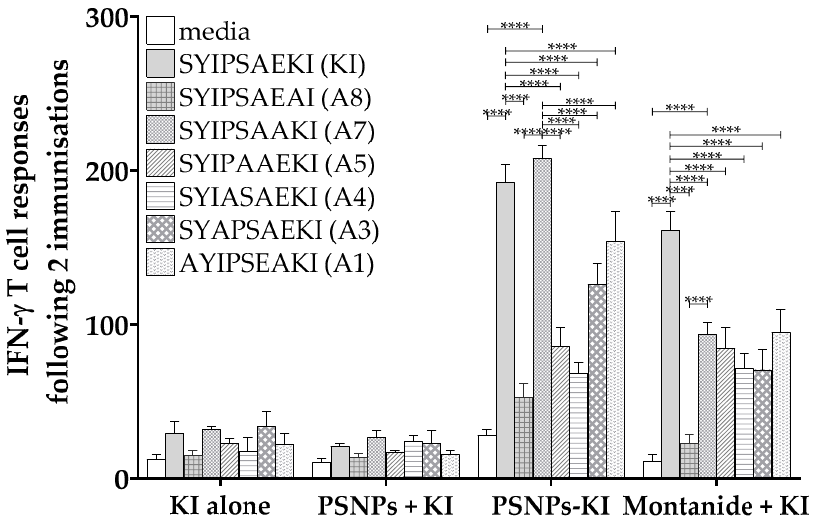
Figure 2. Different patterns of IFN- γ reactivity to alanine altered peptide variants with Montanide adjuvanted or conjugated PSNPs immunized mice. The 6-8 week old BALB/c mice were immunized twice with KI peptide alone (25 µg KI per mouse), PSNPs plus KI (PSNPs + KI) or KI conjugated to PSNPs (PSNPs-KI) (25 µg per mouse KI and 1% solids PSNPs for both groups), or Montanide plus KI (25 µg KI per mouse in 70%/30% v / v Montanide/PBS). Two weeks after the last immunization, splenocytes from immunized mice were harvested and restimulated with altered peptides in an in vitro ELISpot assay for IFN- γ . Data shown as mean +/- SD of spot forming units (SFU)/million cells per assay triplicates (pooled cells from 3–4 mice per group). * p < 0.05, ** p < 0.01, *** p < 0.001, **** p < 0.0001.